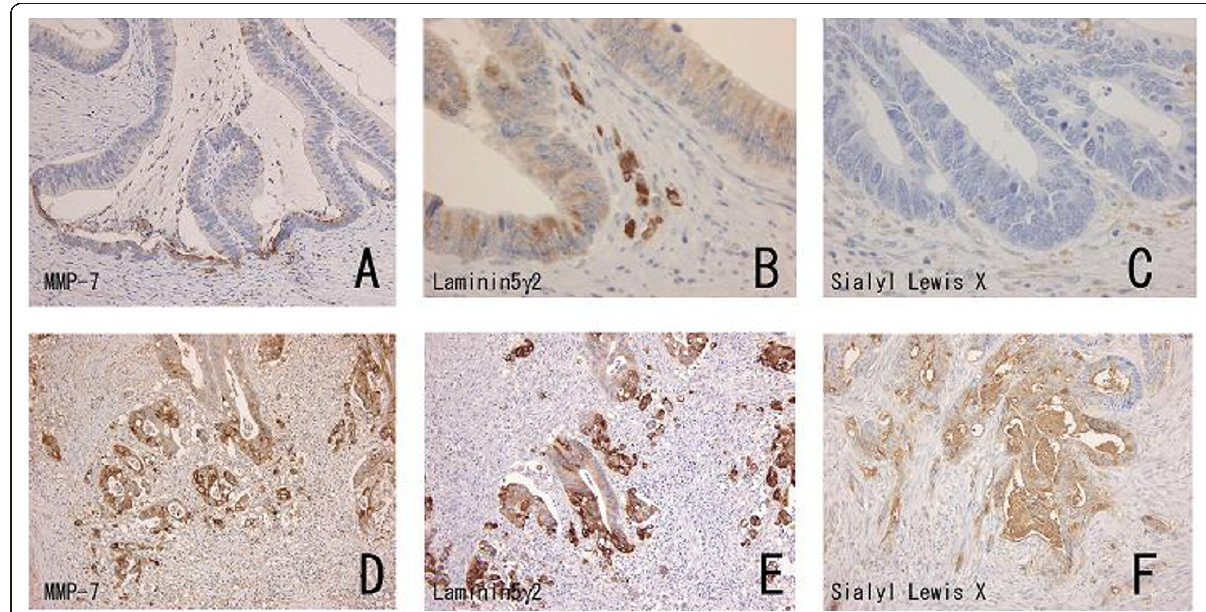
Figure 3 Representative expression of matrix metalloproteinase-7 (MMP-7), laminin-5 g 2, and sialyl Lewis X (Le X ) in an ulcerative colitis (UC)-associated colon carcinoma case (A-C) and a sporadic colon carcinoma case (D-F) . While MMP-7 expression is low in the UC- associated carcinoma with limited tumor budding (A), strong expression is seen in a sporadic carcinoma with frequent tumor budding (D). Laminin-5 g 2 expression observed in invasive fronts of both UC-associated (B) and sporadic (E) cases, especially at tumor budding foci. Note that while no expression of Le X is apparent in a UC-associated case (C), strong immunoreactivity is evident in the sporadic lesion (F).